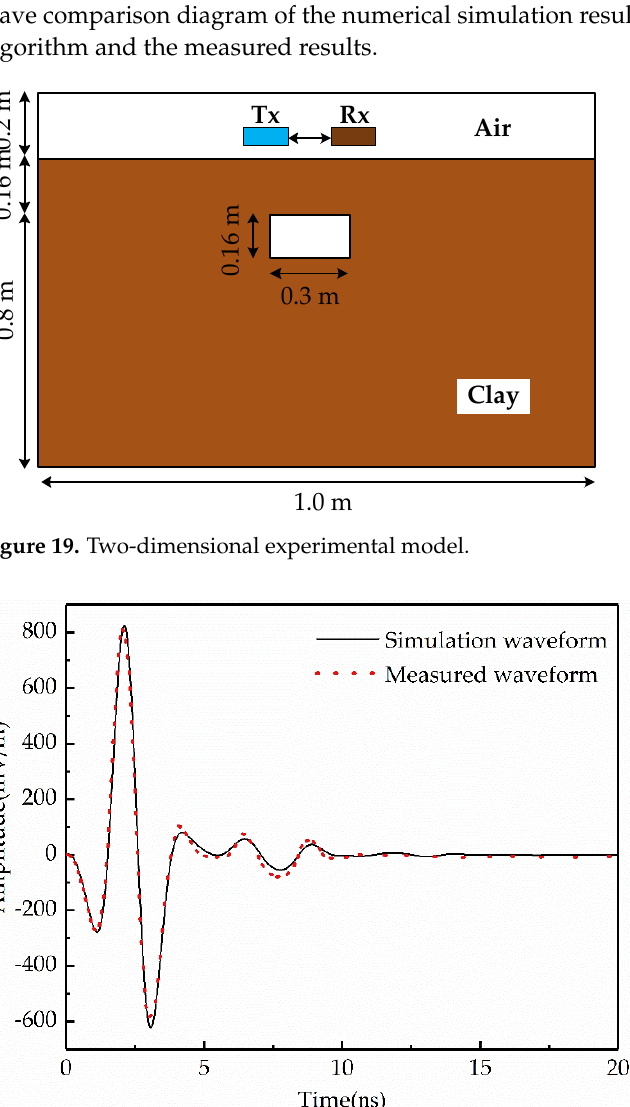
Figure 18. Road radar rectangular cavity experimental diagram.